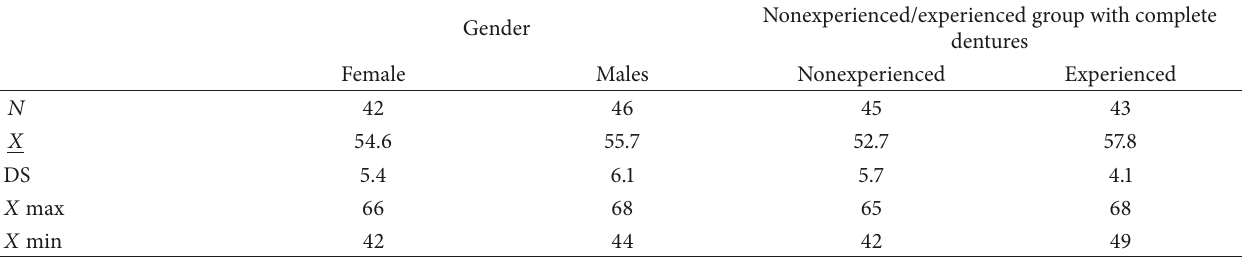
Table 1: Comparison of gender, age, and nonexperienced/experienced group.